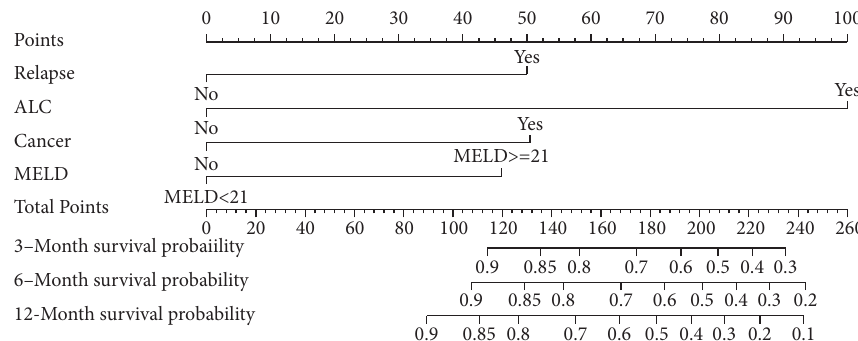
Figure 3: A nomogram for predicting 3-month, 6-month, and 12-month survival of ALD patients. The nomogram was established based on the training cohort.